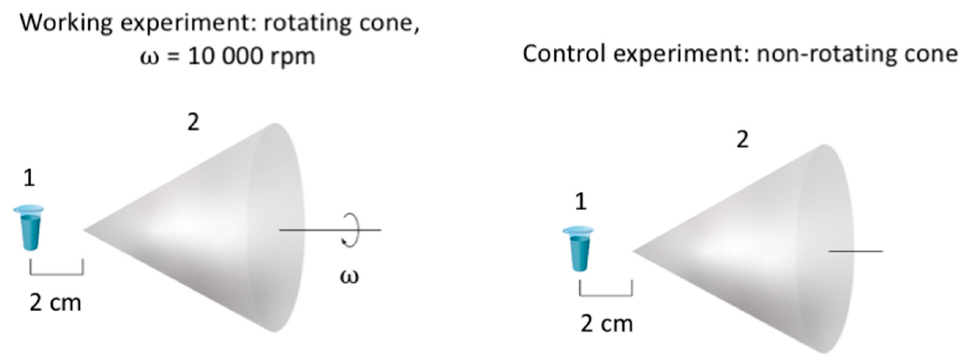
Figure 1. Experimental setup. The working experiments were performed with a cone rotating at 10,000 rpm ( left ), while the control experiments were performed with a non-rotating cone ( right ). The main elements of the setup are indicated by numbers: (1) the test tube with 1 mL of 0.1 µM of HRP solution in 2 mM PBSD (pH 7.4); (2) the rotating cone. The distance between the apex of the cone and the test tube was 2 cm.